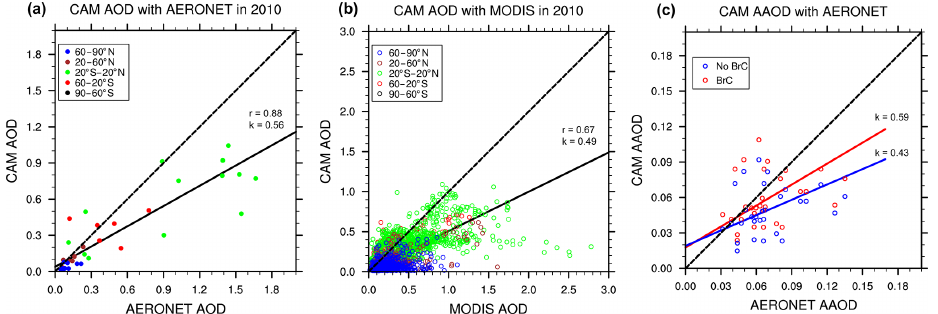
Figure 6. Comparison of monthly mean AOD and AAOD data in 550nm for fire-dominated months and regions (Fig. S1a) of model simulations with the observations for (a) 2010 AERONET AOD, (b) 2010 MODIS AOD and (c) 2005–2014 AERONET AAOD. For (a) and (b) , model data correspond to the same time and location of the observations. The data points in (a) and (b) are color-coded as a function of latitude. The solid line denotes a PC regression line, and the dashed line denotes the 1 : 1 reference line. For (c) , monthly mean values of model data corresponding to AERONET AAOD observations are shown. The solid lines denote PC regression lines for model results with and without BrC absorption, and the corresponding regression slope ( k) values are shown. The dashed line denotes the 1 : 1 reference line.